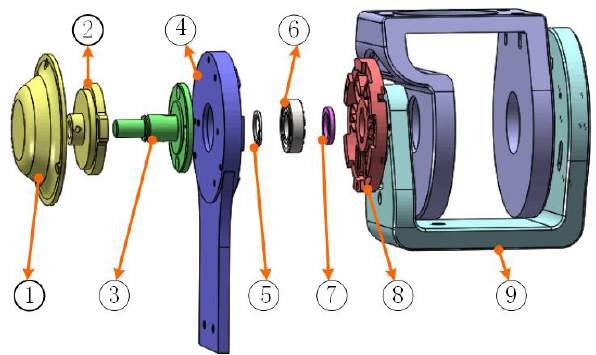
Figure 6. Explosive view of the elastic module. 1: the enclosure, 2: the magnetic encoder, 3: the encoder support, 4: the connection cuff, 5:the snap spring, 6: the bearing, 7: the shaft sleeve, 8: the torsional spring, 9: the limb joint.